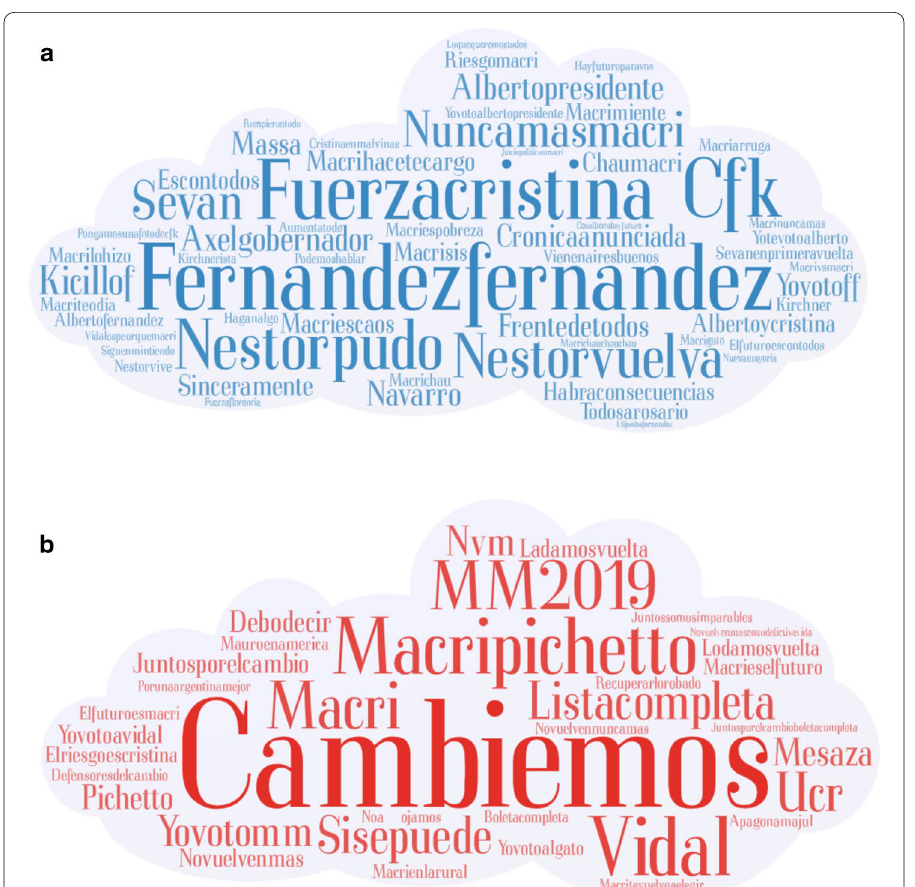
Fig. 8 Hashtag clouds. The dimension of the words is proportional to their frequency in the dataset. a The blue hashtags are the most frequently used in the tweets in favor of Fernández. b The red hashtags are those in favor of